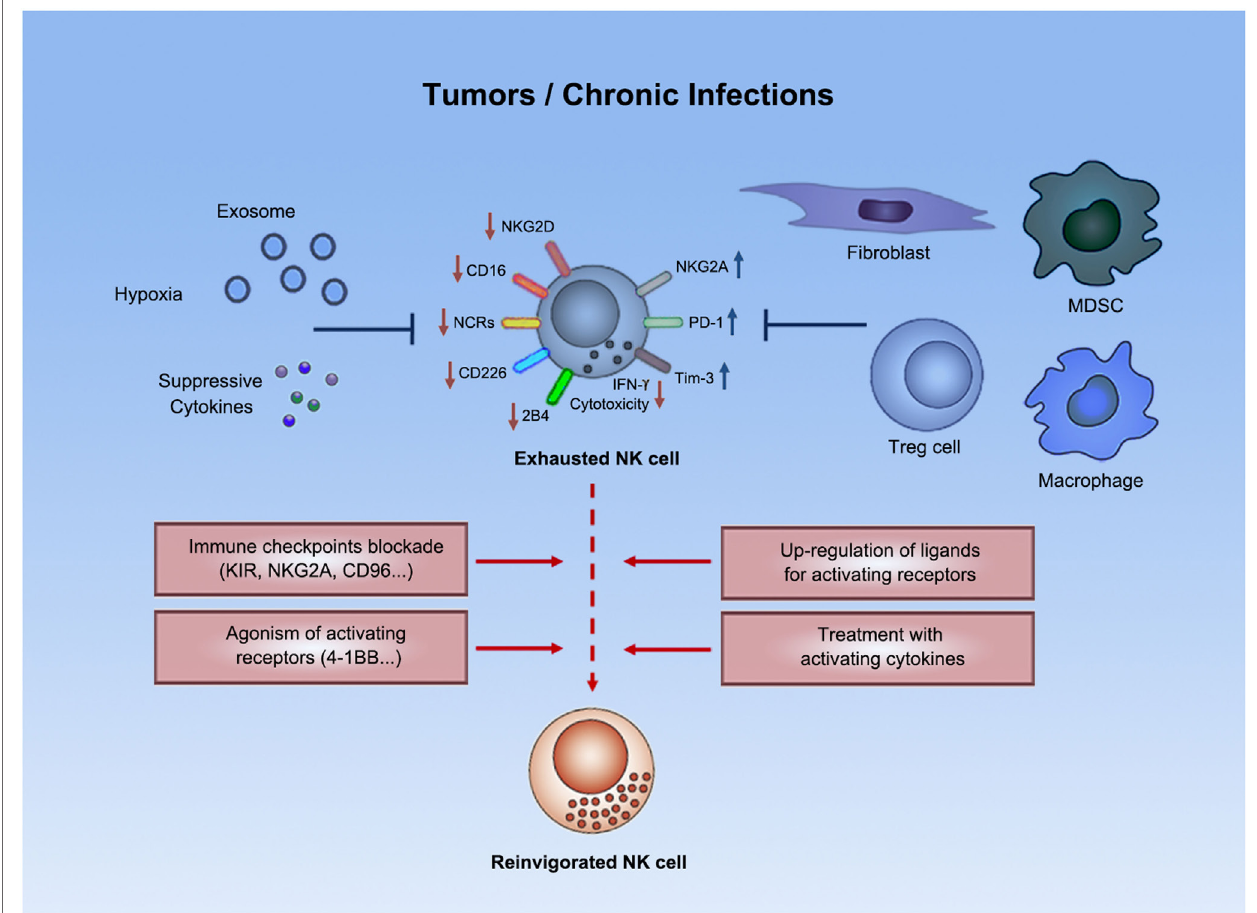
FigURe 1 | Natural killer cell exhaustion. Tumor progression or chronic infections usually leads to exhaustion of NK cells. Exhausted NK cells are characterized by decreased production of effector cytokines (e.g., IFN- γ ), as well as by impaired cytolytic activity. Exhausted NK cells downregulated expression of certain activating receptors and upregulated expression of inhibitory receptors. Both suppressive cells and other suppressive factors (e.g., exosomes, suppressive cytokines, hypoxia, etc.) in tumors or chronic infections might contribute to such exhausted status. Emerging strategies (e.g., immune checkpoint blockade) could potentially reverse NK cell exhaustion to boost antitumor or anti-infection